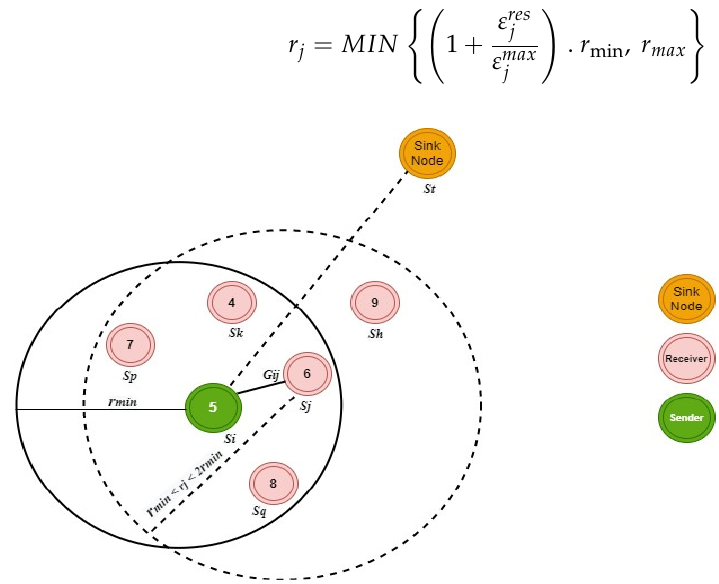
Figure 2. Candidate discovery